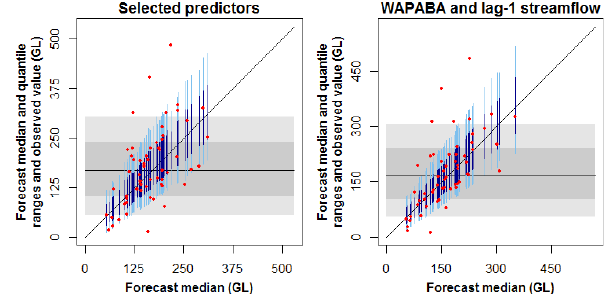
Fig. 9. Forecasts of inflows into Upper Yarra Reservoir for the July- August-September season. Using selected predictors, RMSEP skill score=5% and CRPS skill score=3%, using WAPABA simula- tions and lag-1 streamflow as predictors RMSEP skill score=17%, and CRPS skill score=12%. (legend as per Fig.